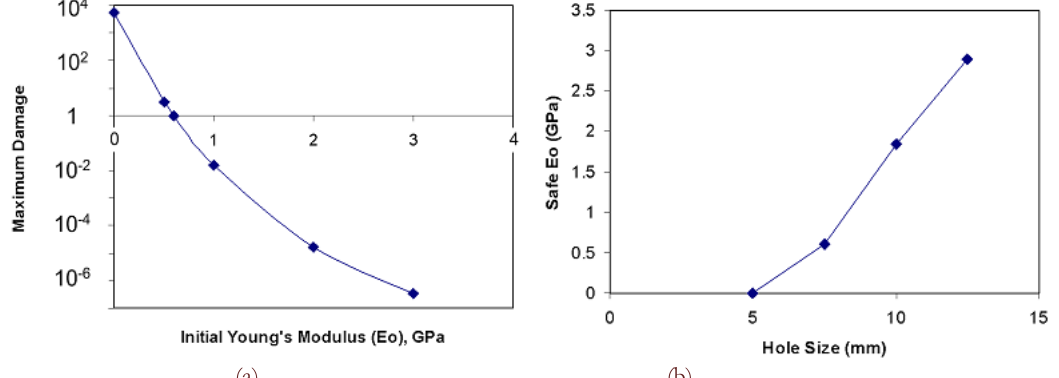
Figure 8: (a) Variation of peak damage amount with Young’s modulus of the bone graft material; (b) Specification for the safe value of E o (i.e. the value above which failure will not occur) as a function of hole